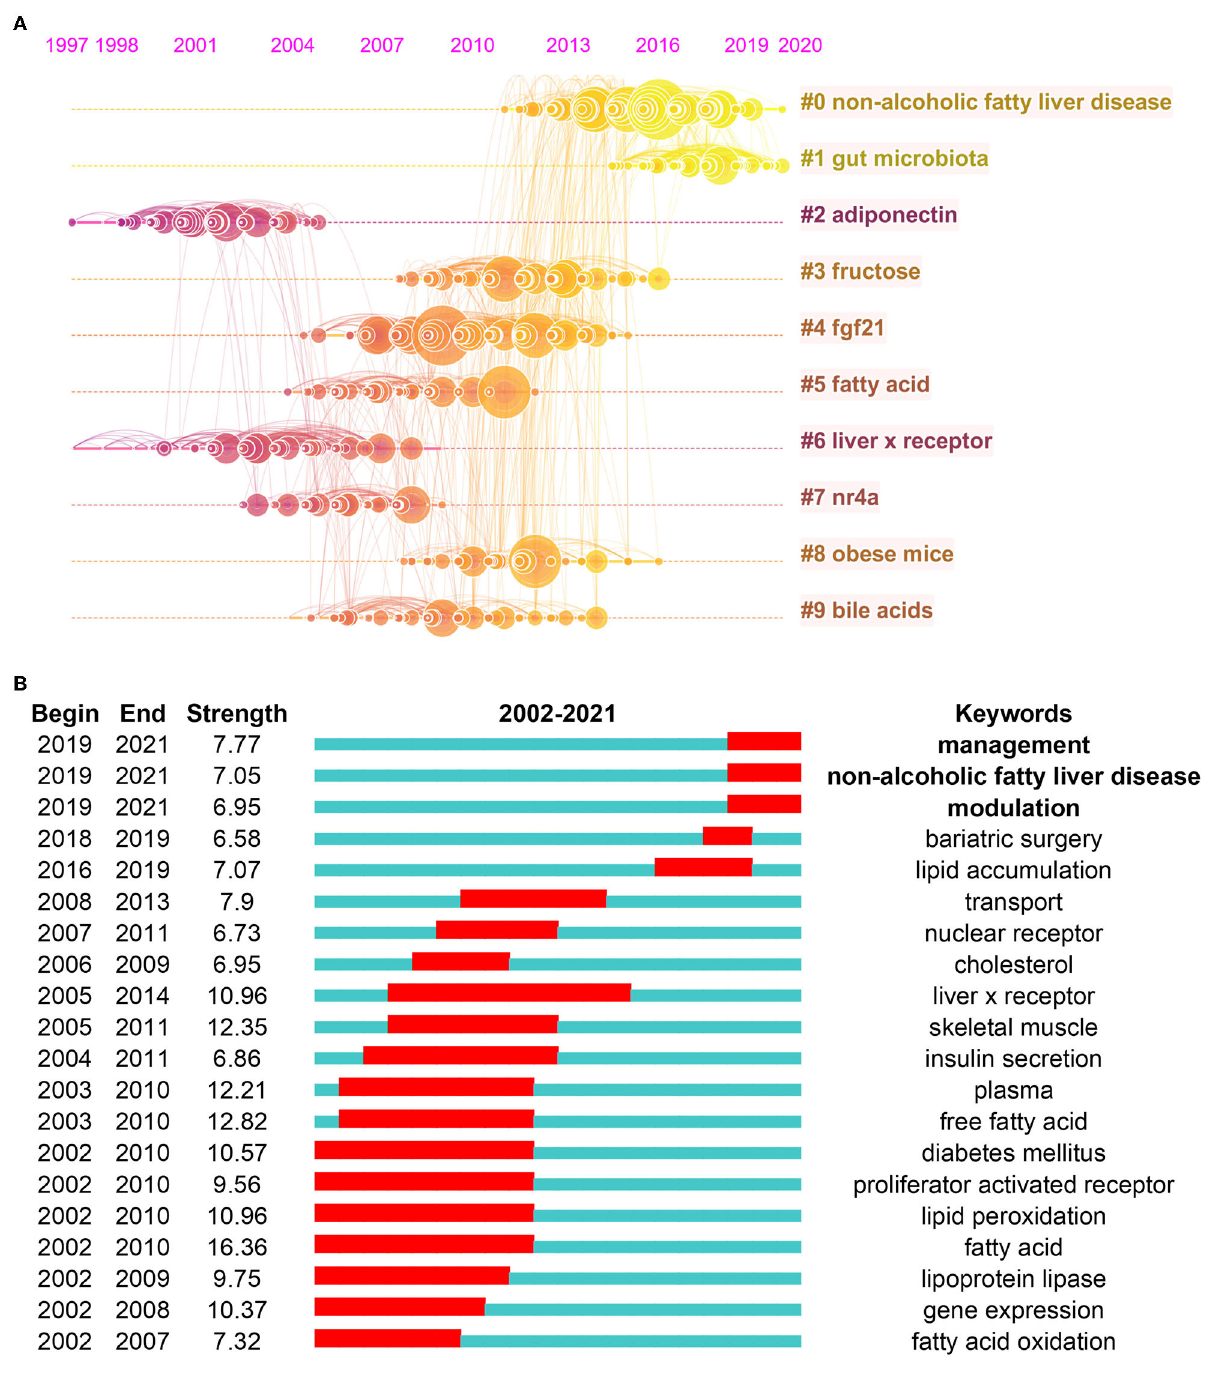
FIGURE 6 | (A) A timeline view of the top 10 largest clusters of citing articles in the field of hepatic glycolipid metabolism. Right side = cluster labels. (B) Keywords with the strongest burst strength of the 4,856 citing articles on hepatic glycolipid metabolism research between 2002 and 2021. Keywords marked in red indicate a sudden increase in usage frequency of this keyword during that period. Blue represents a relatively unpopular time